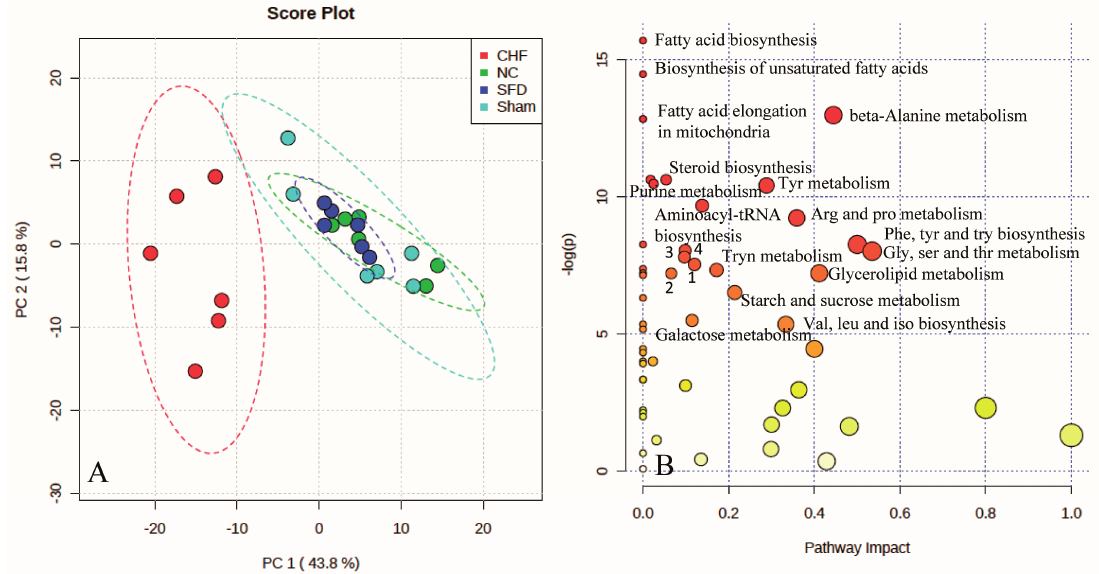
Figure 2. Scores plots for principle component analysis model of rat urine data in the CHF, sham surgery, normal control, and SFD-treated groups ( A ); Metabolomic pathway analysis overview ( B ) indicating select metabolic pathways that are significantly affected